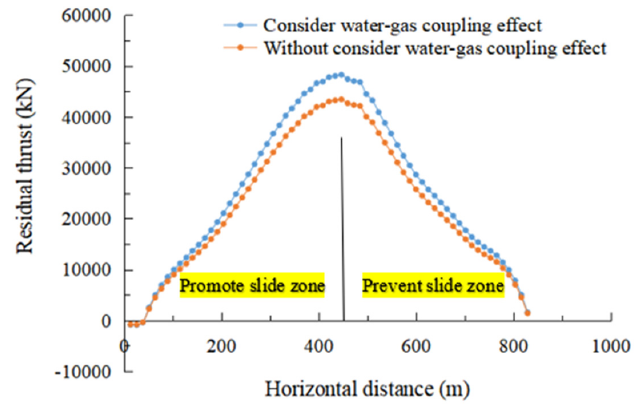
Figure 16. Diagram of the distribution of residual